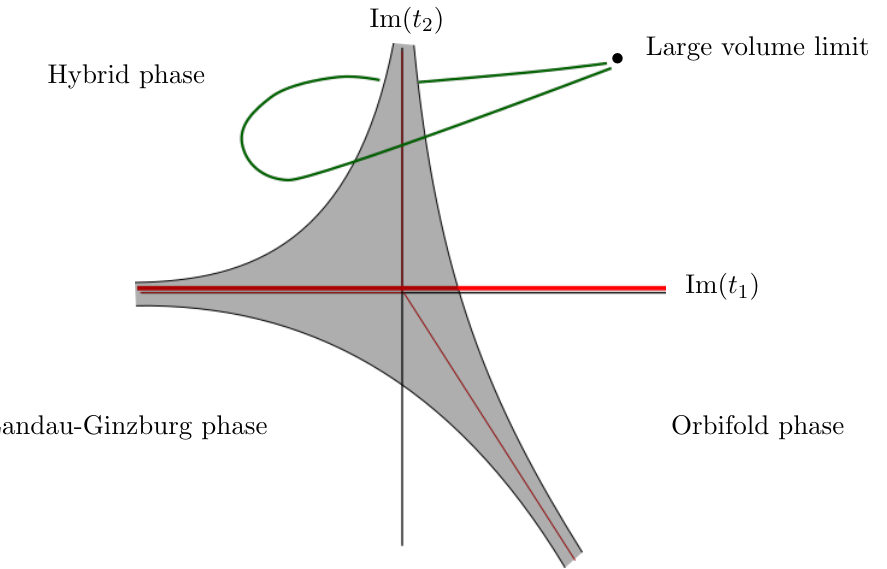
Figure 1 . Diagram of the FI-parameter space of the gauged linear sigma model that realizes the non-linear sigma model into the degree 18 hypersurface inside P (1 ; 1 ; 1 ; 6 ; 9). The amoeba of the principal component of the discriminant, which corresponds to a non-compact Coulomb branch, is indicated in grey. Two geometric phases on the right are seperated by a mixed Coulomb-